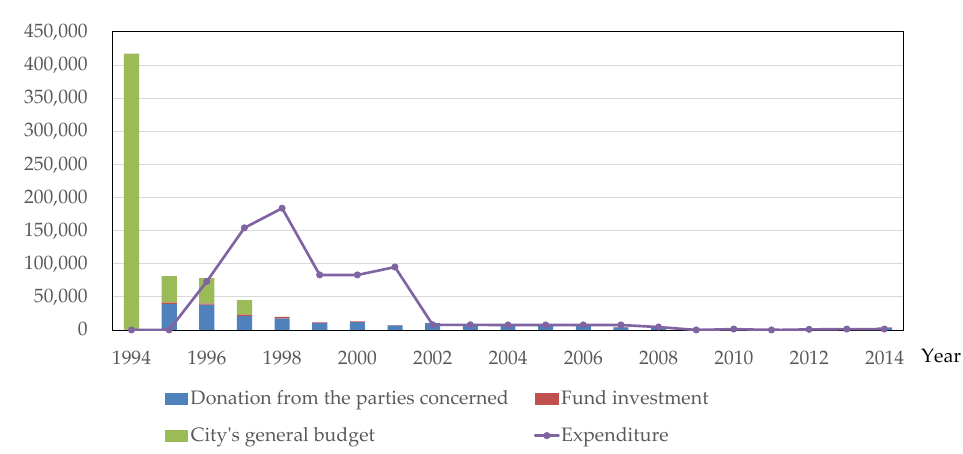
Figure 2. Revenue and expenditure for the groundwater purification fund.